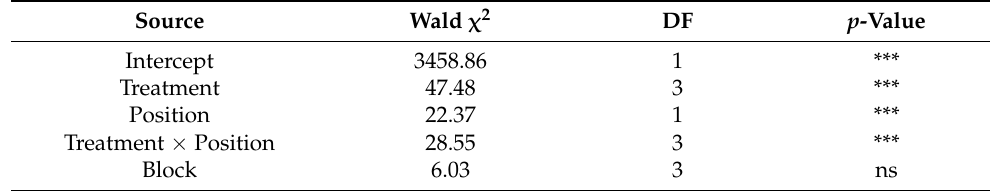
Table A1. Results of repeated-measures analysis with generalized linear model testing the effects of the independent variables block, treatments, positions, and their interaction on ground cover percentage.